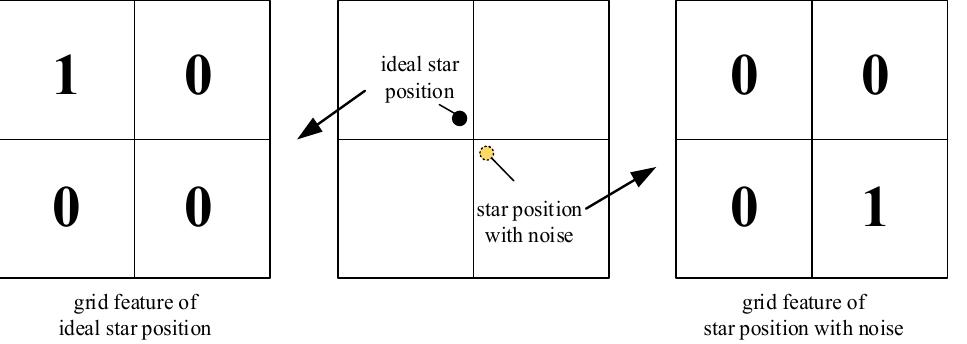
Figure 5. Demonstration of the poor positioning tolerance of traditional feature extraction.